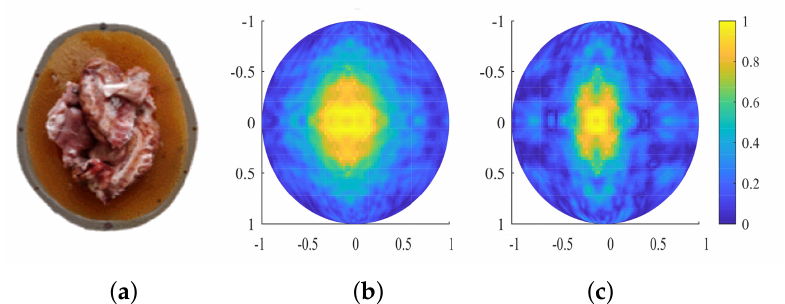
Figure 4. Experimental results for ( a ) lamb brain phantom using ( b ) DMAS and ( c ) DAS algorithm. It can be noted that DMAS produce accurate results compared to